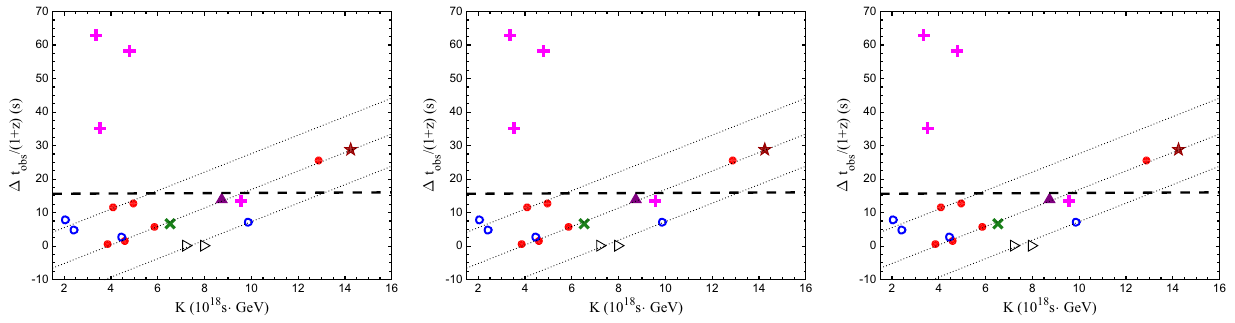
Fig. 23 The Δ t obs /( 1 + z ) – K plots from NaI, BGO and LLE data. The dots refer to events from long bursts and the triangles refer to the events from short bursts. The middle dotted line in each plot refers to the mainline. For each plot, nine events out of 17 fall on the mainline. As the LLE data for GRB 100414A seem not available in the web-